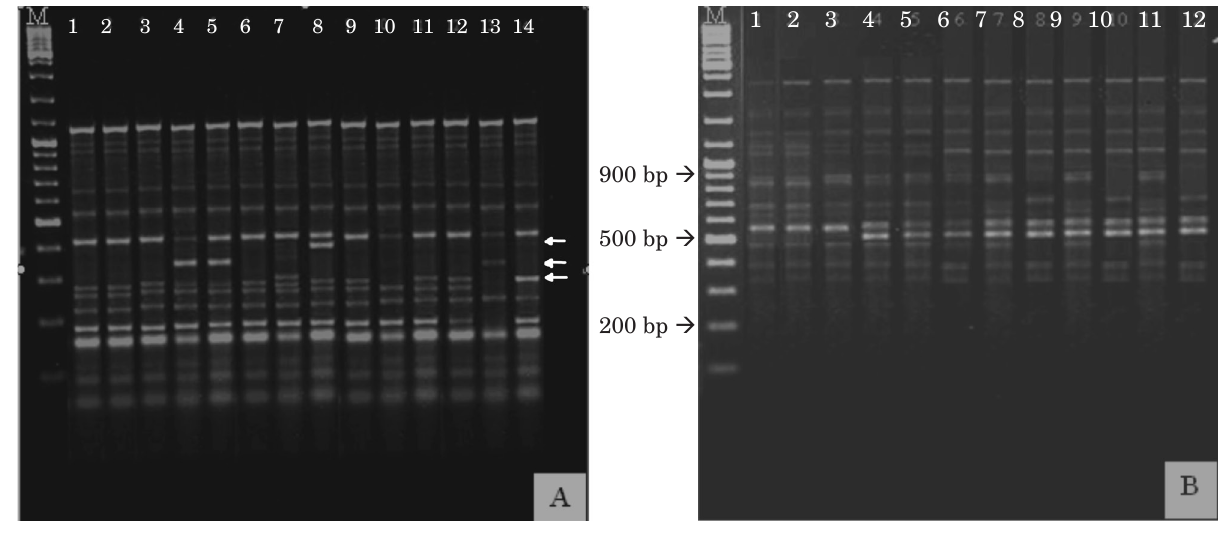
Figure 3. rep-PCR fingerprint patterns of Dickeya dadantii strains isolated from different hosts. A. ERIC-primers: 1, EchSCRI3739; 2, EchSCRI3739; 3, Po5; 4, Po6; 5, T; 6, Cr3; 7, Po7; 8, S4; 9, L3; 10, O3; 11, O4; 12, T3; 13, Pe3; 14, Cb4; M, 1 Kb DNA molecular marker. B. BOX A1R: 1, EchSCRI3739; 2, T3; 3, O3; 4, Po6; 5, T4; 6, Cr3; 7, Po5; 8, S4; 9, Cb4; 10, Pe3; 11, O4; 12, L3; M, 1 Kb DNA molecular marker. Differences in banding patterns between strains are highlighted by